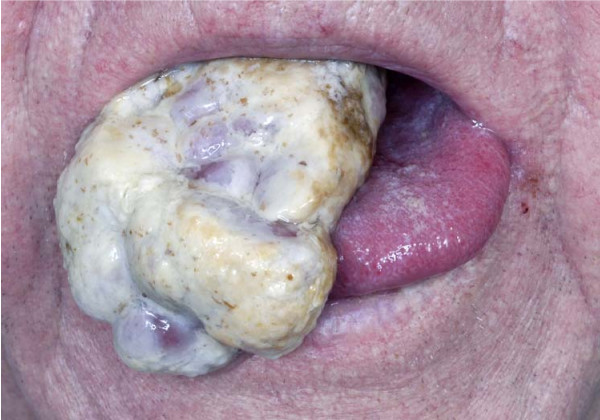
Tongue metastasis.